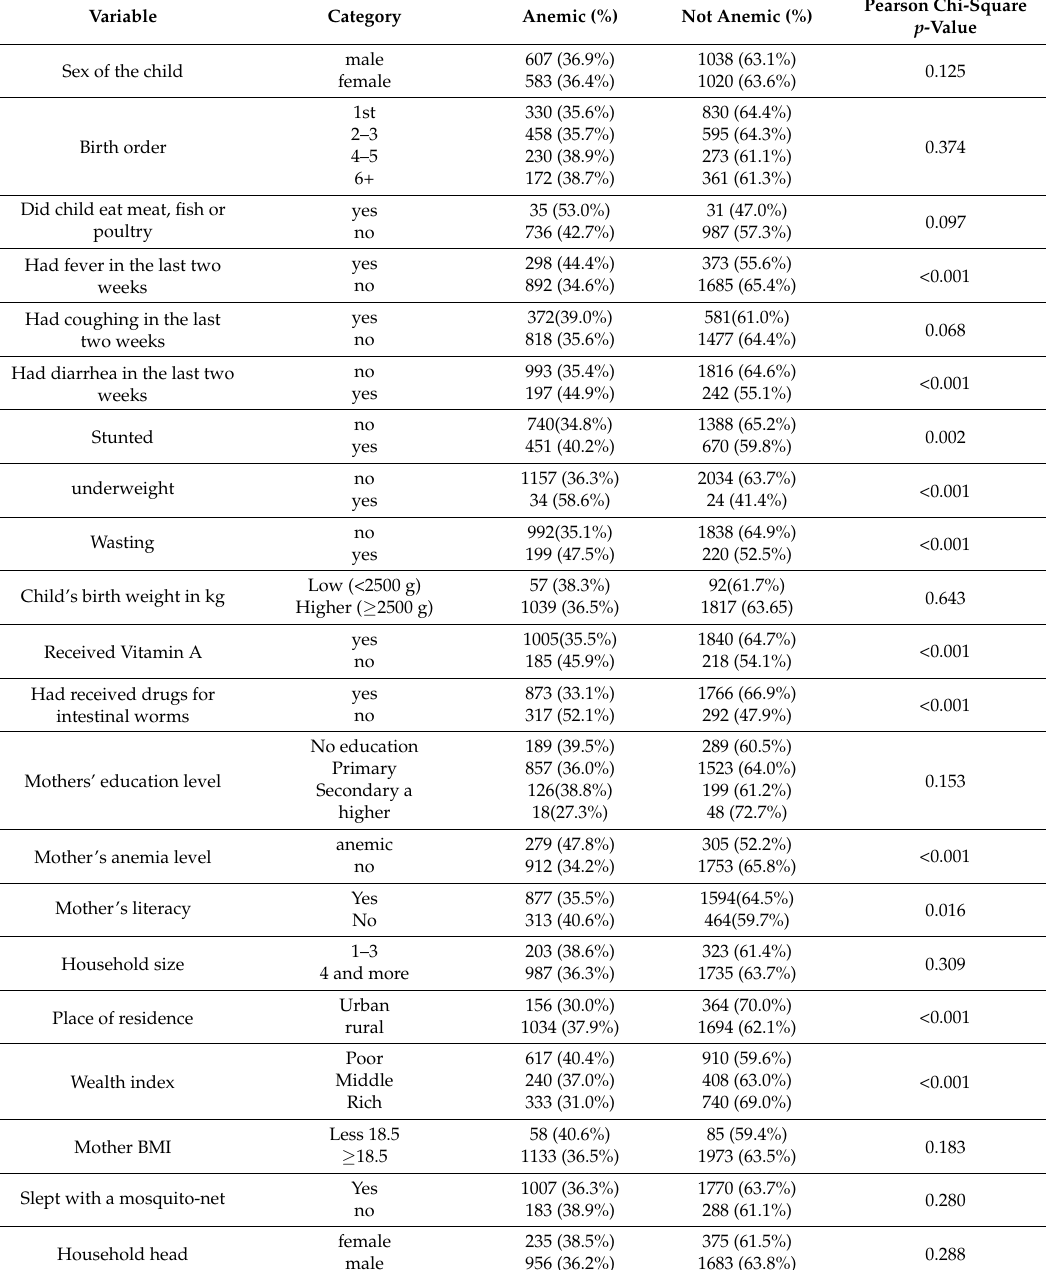
Table 1. Childhood anemia by categorical